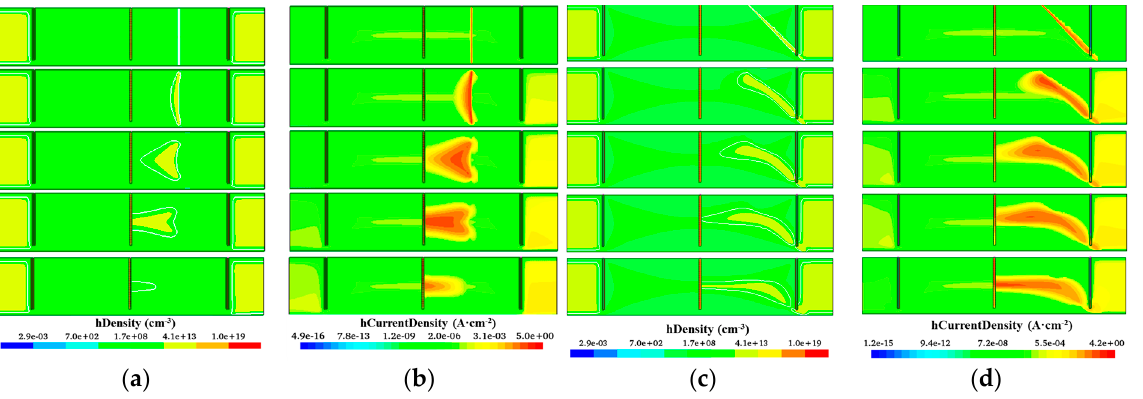
Figure 10. Hole density and hole current density at different times of a 3D large-area trench electrode silicon detector without floating ring: ( a ) Hole density, α = 90 ◦ ; ( b ) Hole current density, α = 90 ◦ ; ( c ) Hole density, α = 45 ◦ ; ( d ) Hole current density, α = 45 ◦ .